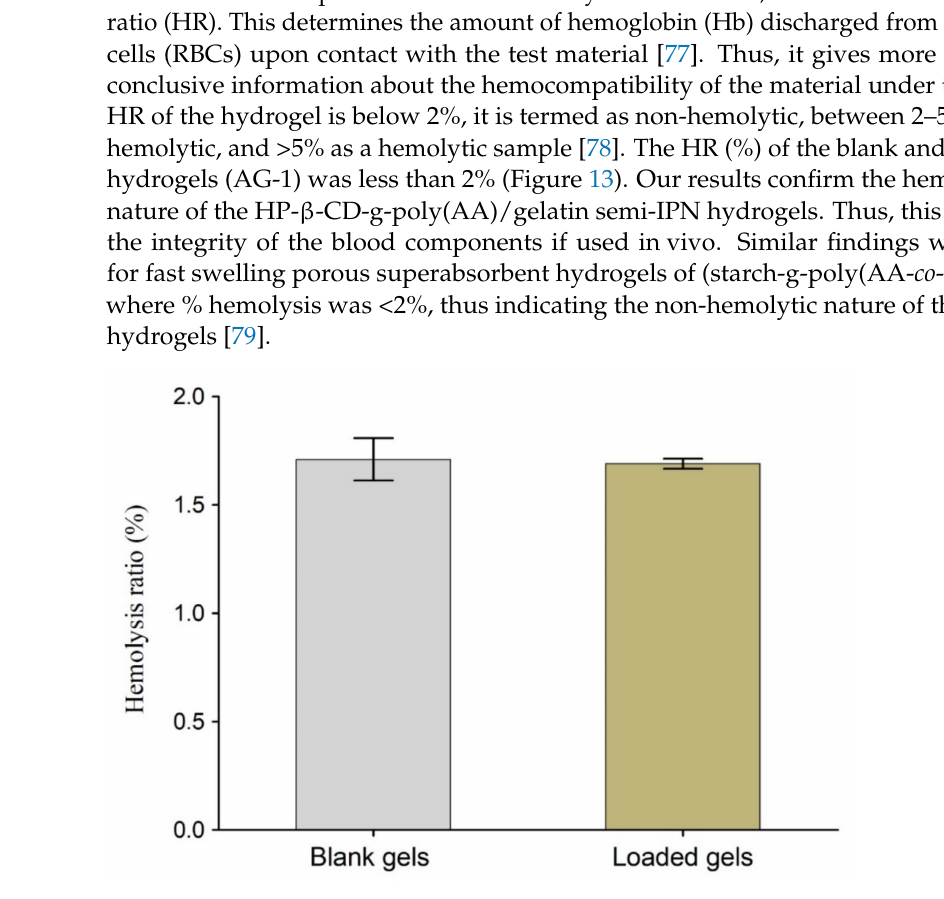
Figure 13. Hemocompatibility study of blank and drug-loaded semi-IPN hydrogels (AG-1). Error bars represents means ± SD ( n =